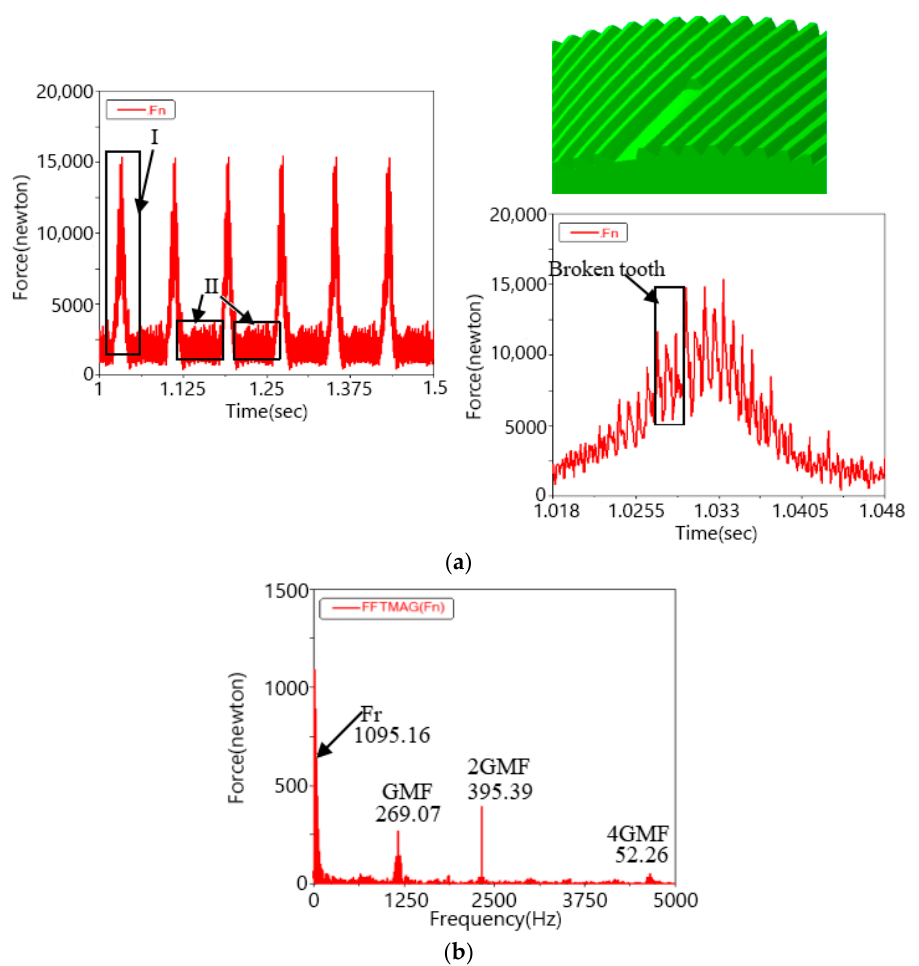
Figure 13. ( a ) Schematic diagram of 1/2 broken tooth and normal meshing force with its zoom magnified image of position I; ( b ) frequency spectrum.